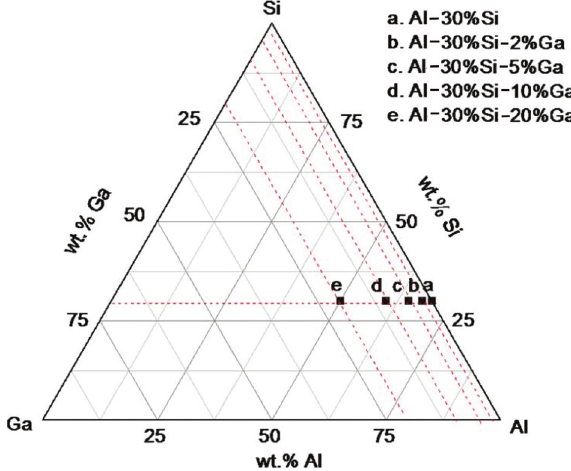
Figure 2: Compositions of Al – Si – Ga alloys in this work.